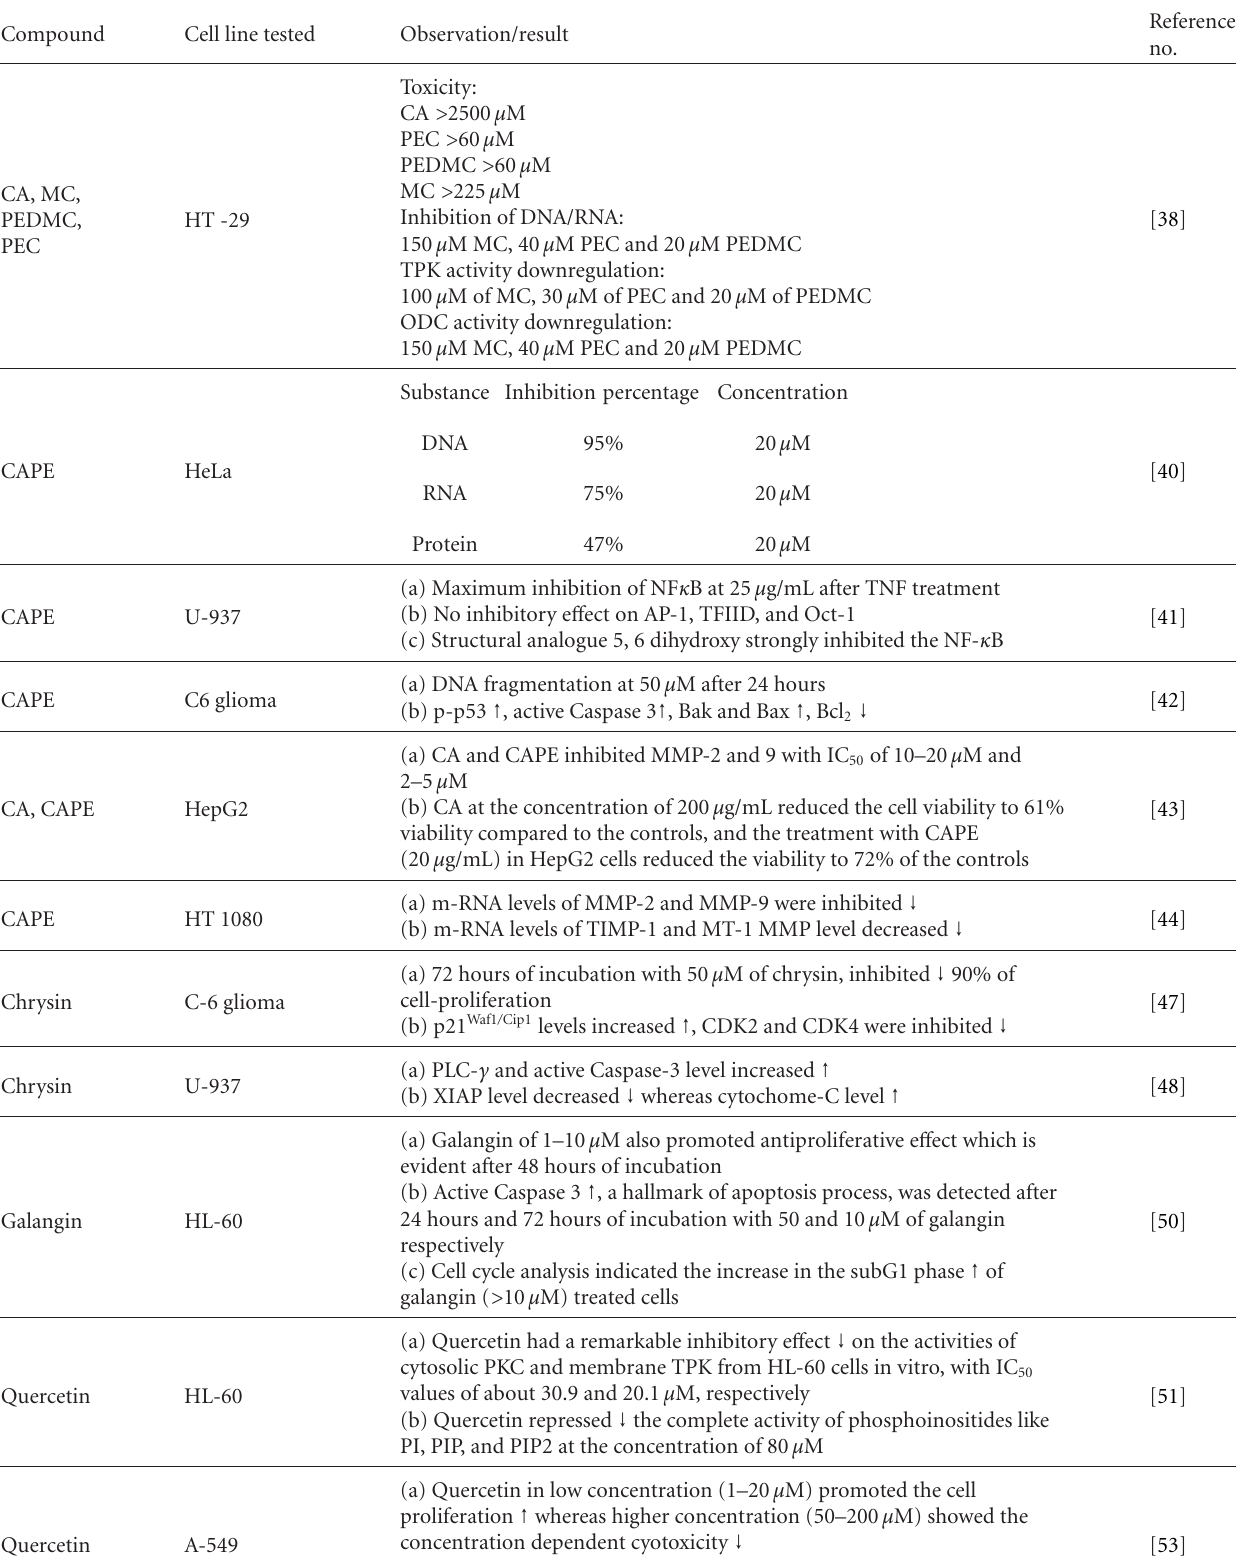
Table 2: Summary of in vitro studies of honey